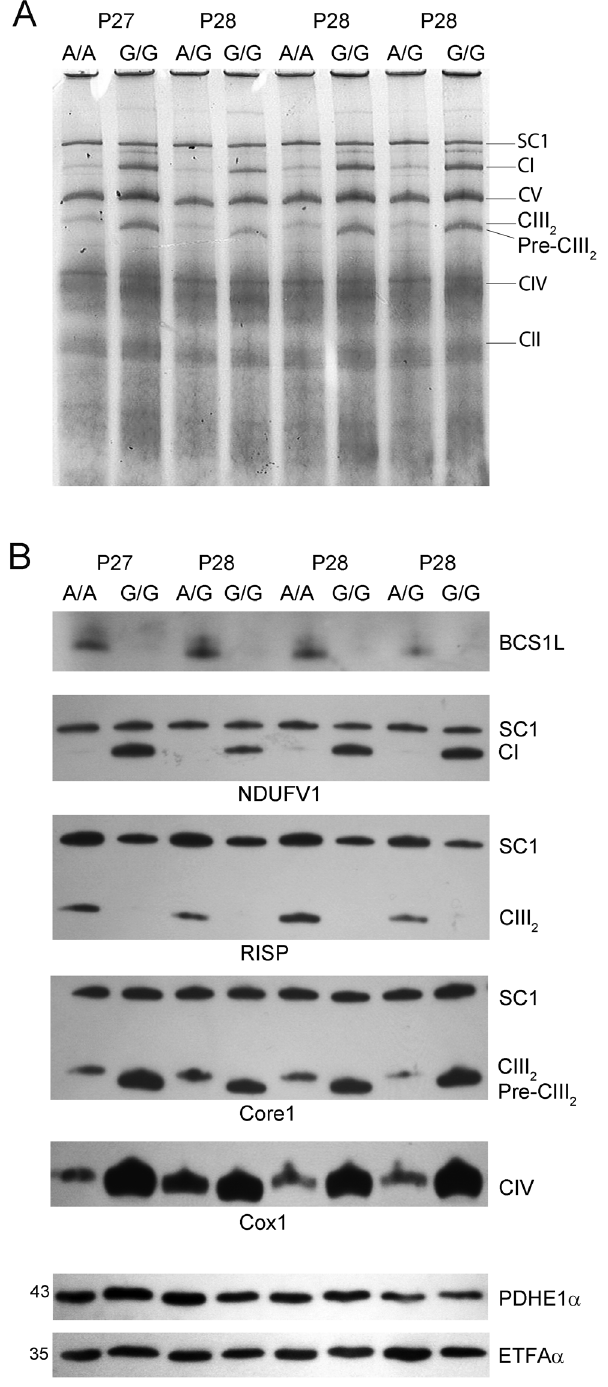
Figure 3. Low amount of RISP in sick Bcs1l G/G mice is associated with increased amount of free pre-CIII 2 and CI. A. Representative blue native gel electrophoresis of isolated mitochondria from Bcs1l G/G (G/G) and control (A/A and A/G) mice 27–28 days old. The bands of respiratory chain complexes and supercomplexes are visualized. B. In isolated liver mitochondria from Bcs1l G/G , BNGE followed by Western blot shows the lack of BCS1L. Supercomplex (SC1) composition was assessed with antibodies against NDUFV1, RISP, Core1 and subunit Cox1. PDHE1 a and ETFA a antibodies were used as loading controls.